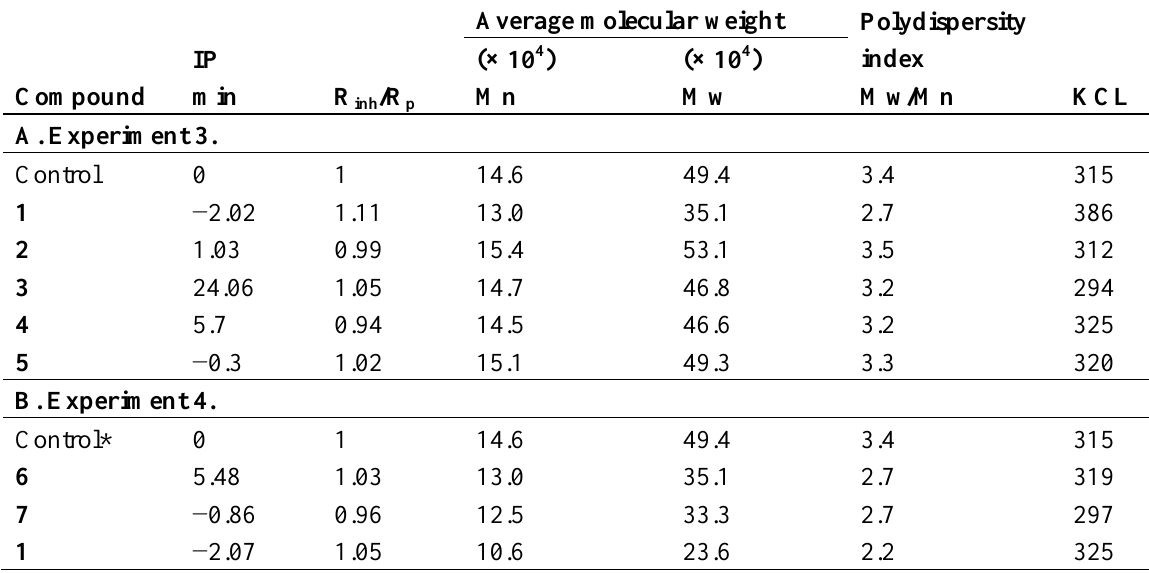
Table 4. Effect of thiobarbituric acid derivatives on the average molecular weight of polymer formed during polymerization of MMA initiated by thermal decomposition of AIBN, based on reported data